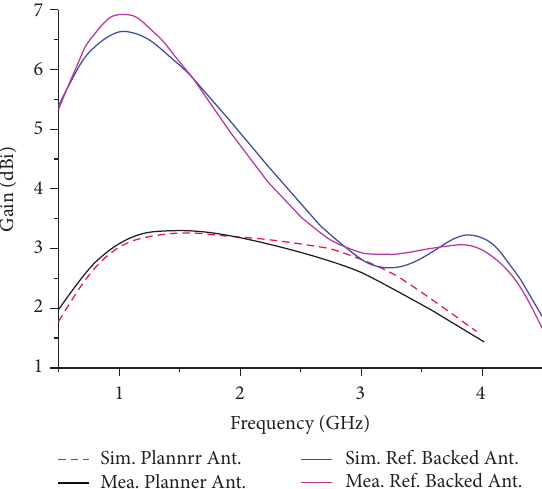
Figure 10: Simulated and measured gain of the proposed antenna at the different gaps between the reflector and the